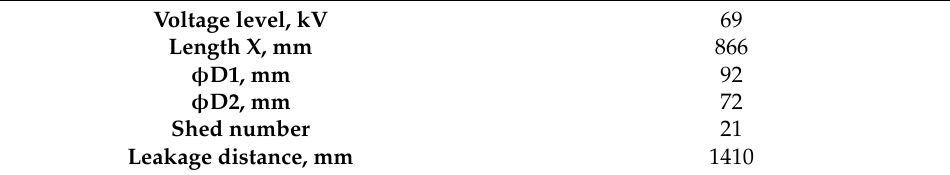
Table 1. Sediver composite insulator characteristics [19].